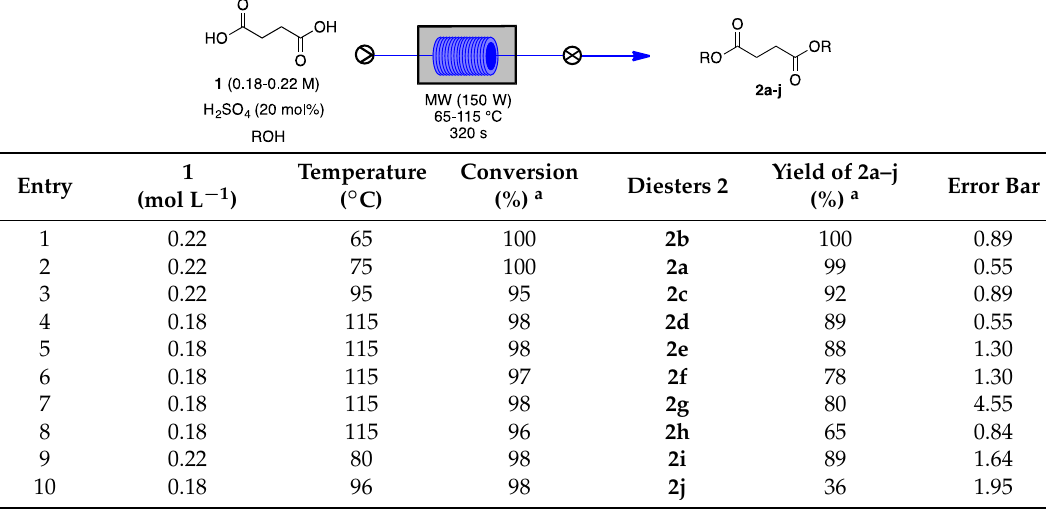
Figure 1. Selected dialkyl succinates 2a – j . Table 4. Scope of the microwave-assisted continuous flow dialkyl succinate 2a – j synthesis at 75 ◦ C.